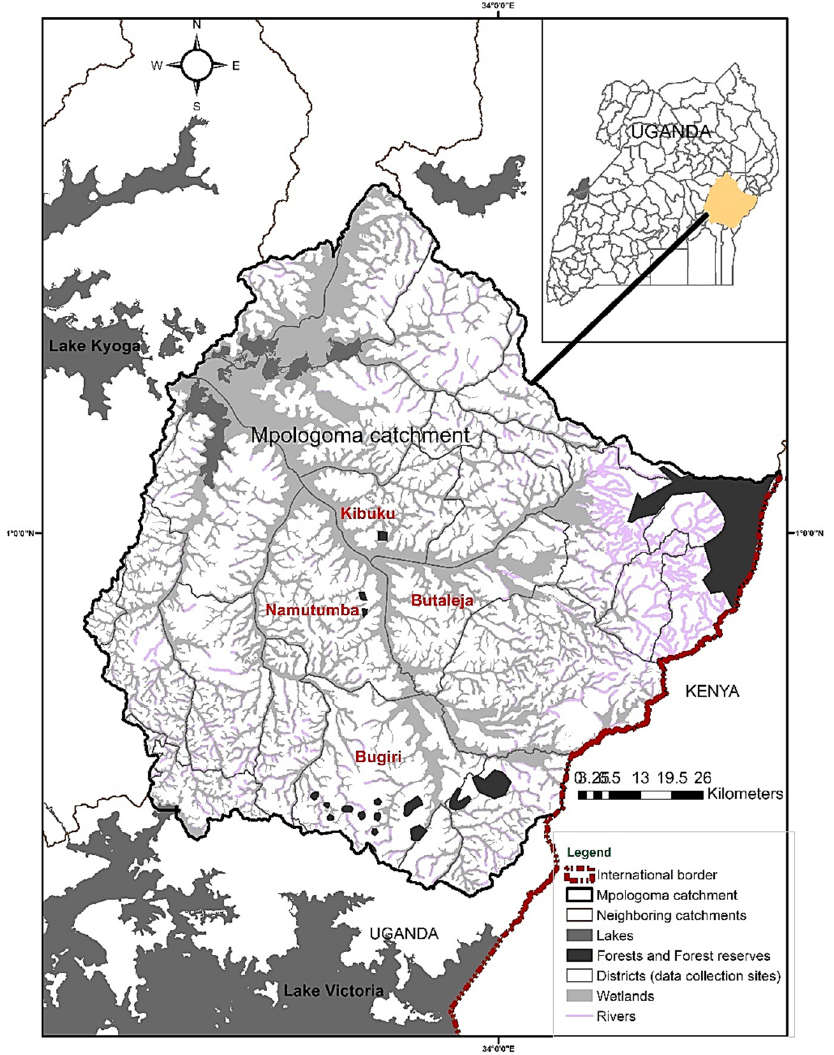
Figure 1. Location of the data collection sites (districts) in Mpologoma catchment, Eastern Uganda.